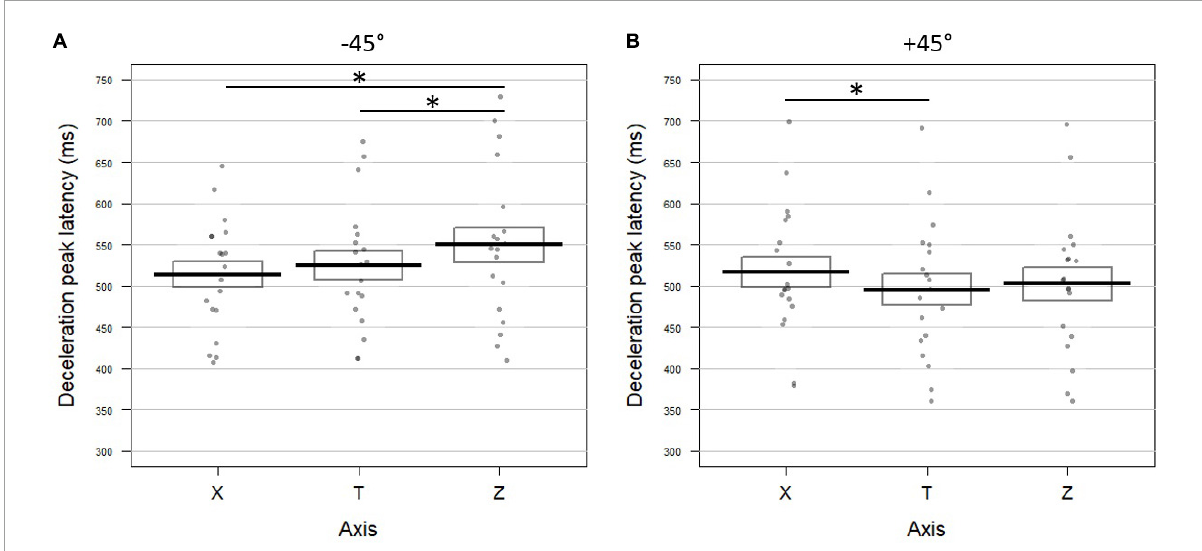
FIGURE7 Effect of verbal incongruency on the temporal dynamic of movements toward (A) –45 ◦ and (B) +45 ◦ targets in Experiment 2. Latencies (in milliseconds) of the deceleration peak extracted from the horizontal (X), tangential (T), and vertical (Z) axes when hearing an incongruent verbal instruction ( A: “à droite en bas”/ right bottom ; B: right panel: “à droite en haut”/ right up ; see Figure 6 for conventions; ∗ indicates a significant difference between conditions). (A) When pointing downward toward –45 ◦ targets, deceleration peaked later on Z than on T ( t = 3.13; p = 0.003) and on X ( t = 3.00; p = 0.002). (B) For movements upward to +45 ◦ targets, the deceleration peak occurred later on X than on T ( t = 2.42; p = 0.024), yet the Fischer combination test on all parameters was not significant (T vs. X: K = 5.62; p =